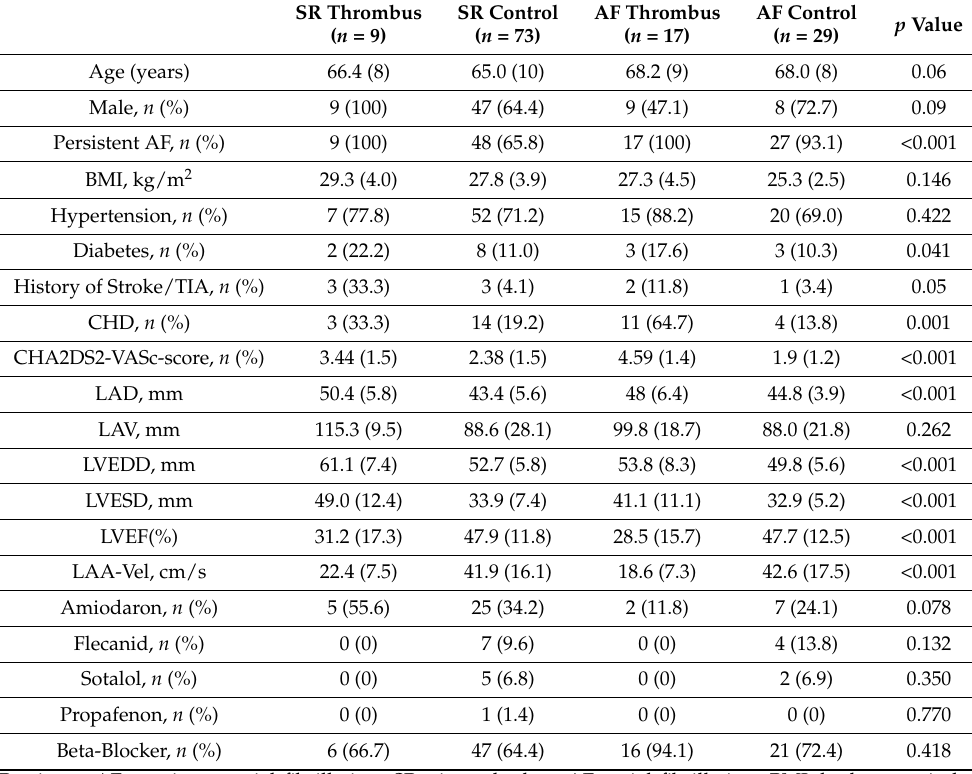
Table 2. Baseline characteristics in each